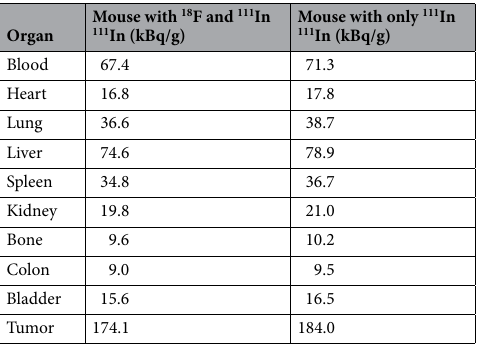
Table 1. The 111 In radioactivity of some organs and the tumors measured by an auto-well gamma counter after excision from tumor-bearing